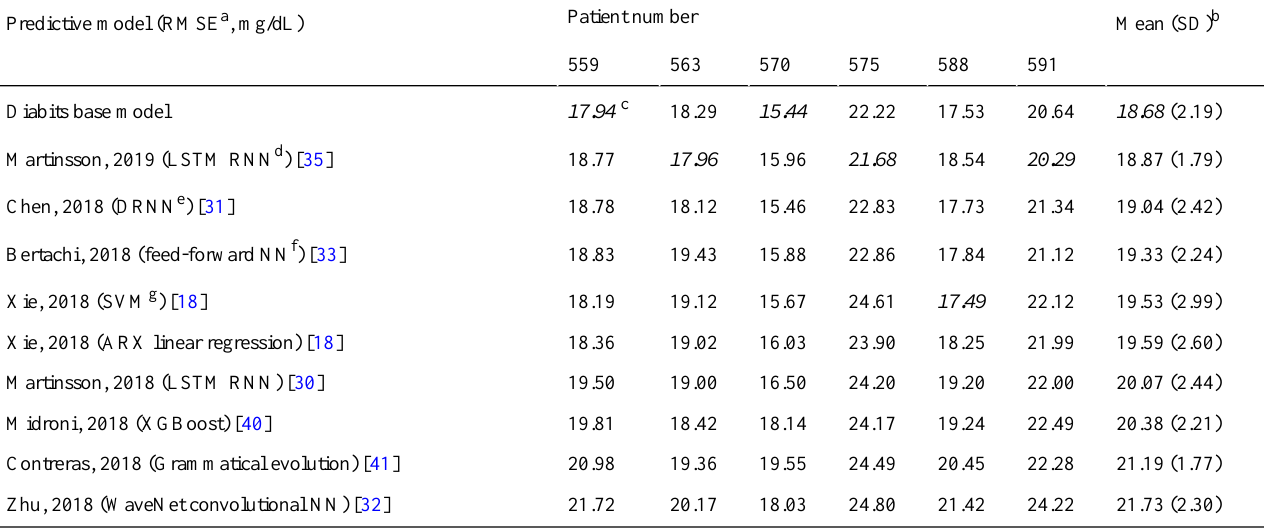
Table 3. Root mean square error (mg/dL) of 30-min prediction accuracy of the base Diabits model for 6 patients in the 2018 Ohio type 1 diabetes mellitus data set compared with the best of the published results of 2018 Blood Glucose Level Prediction Challenge [51] on the same